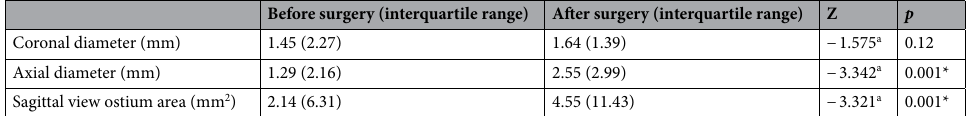
Table 3. Median ostium dimensions of patent ostia before and after operation and the statistical significance of difference analysed with Wilcoxon signed ranks test between pre- and postoperative results. *These changes statistically significant ( p < 0.05). a Based on negative ranks.